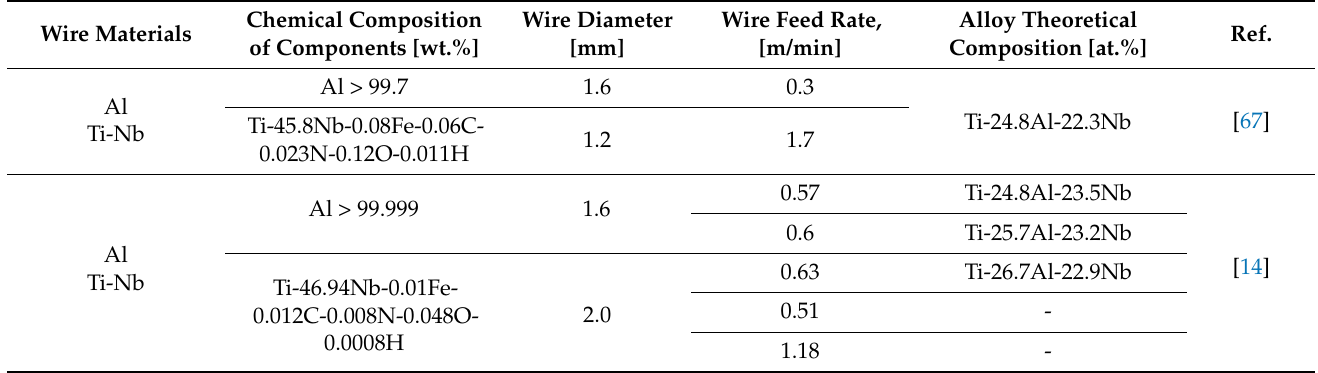
Table 1. The nominal chemical composition of Ti-Nb wire and theoretical composition of the Ti 2 AlNb- based alloy fused using AM process, diameter and feed rate of the